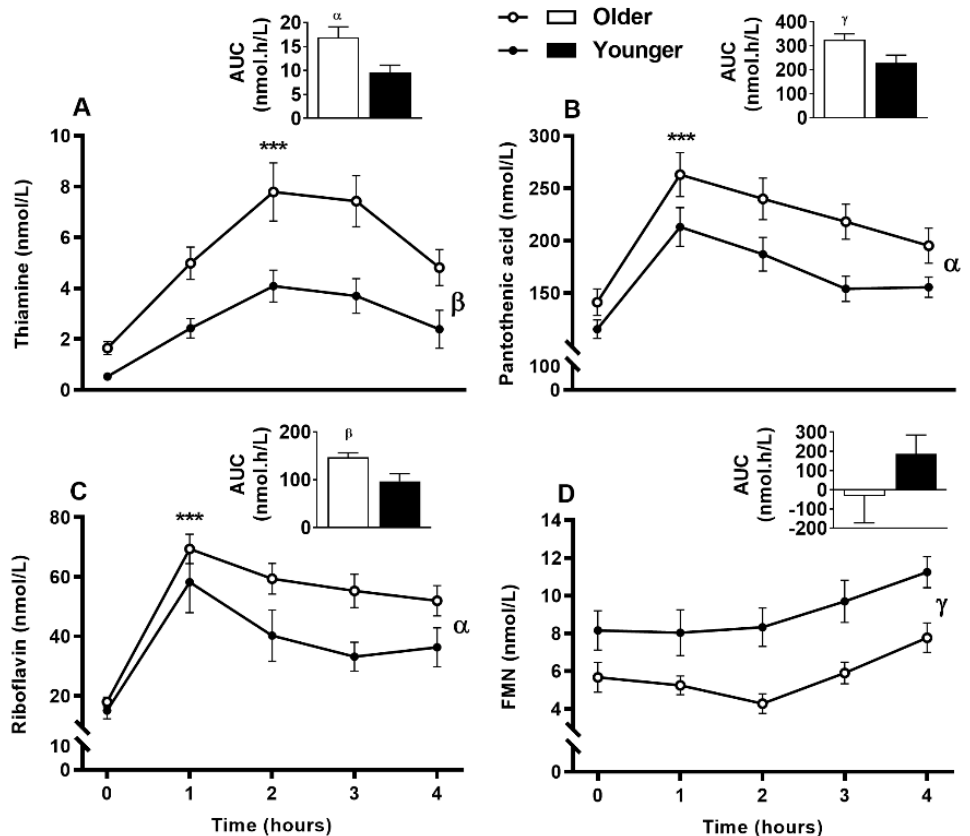
Figure 5. Plasma response of ( A ), thiamine ( B ), pantothenic acid ( C ), riboflavin, and its vitamer ( D ), flavin mononucleotide (FMN) at fasting (time, 0), hourly until four hours (time, 1, 2, 3, 4) and the four hour incremental area under the curve (AUC, represented by bar-graphs) following a single multivitamin and mineral supplement ingestion in older and younger adults. Data for multiple time points was compared using general linear mixed model with time as repeated and age as fixed factors. AUC data was compared with general linear univariate analysis of variance with age as fixed factor.